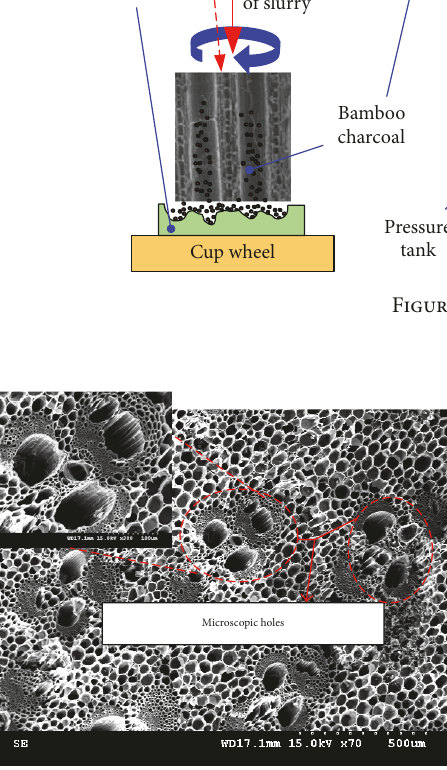
Figure 2: SEM image of bamboo charcoal structure.